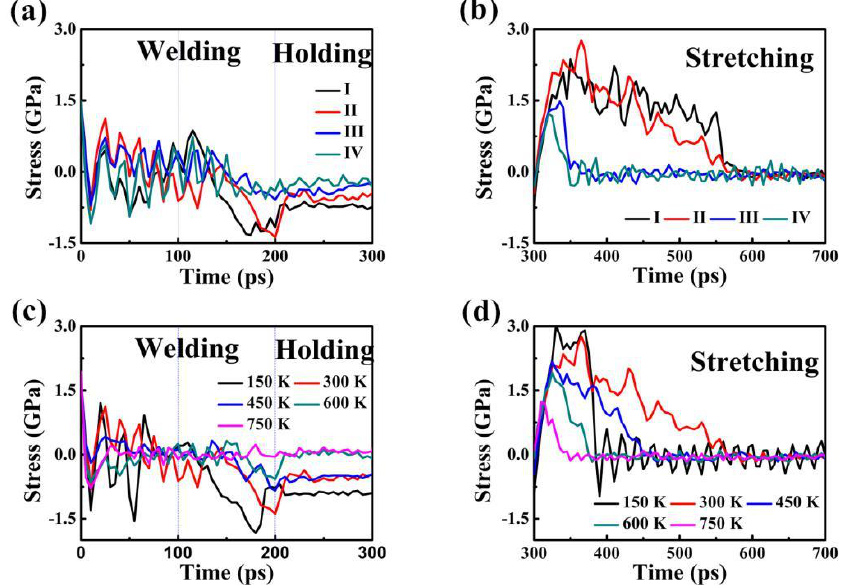
Figure 4. Stress-time curves at longitudinal direction of Sample I, II, III and IV assembled structures at time of ( a ) 0 to 300 ps and ( b ) 300 to 700 ps. Stress-time curves of Cu–Cu nanobearing-nanosleeve structures versus time at different temperatures (150–750 K) during ( c ) 0 to 300 ps ( d ) 300 to 700 ps.